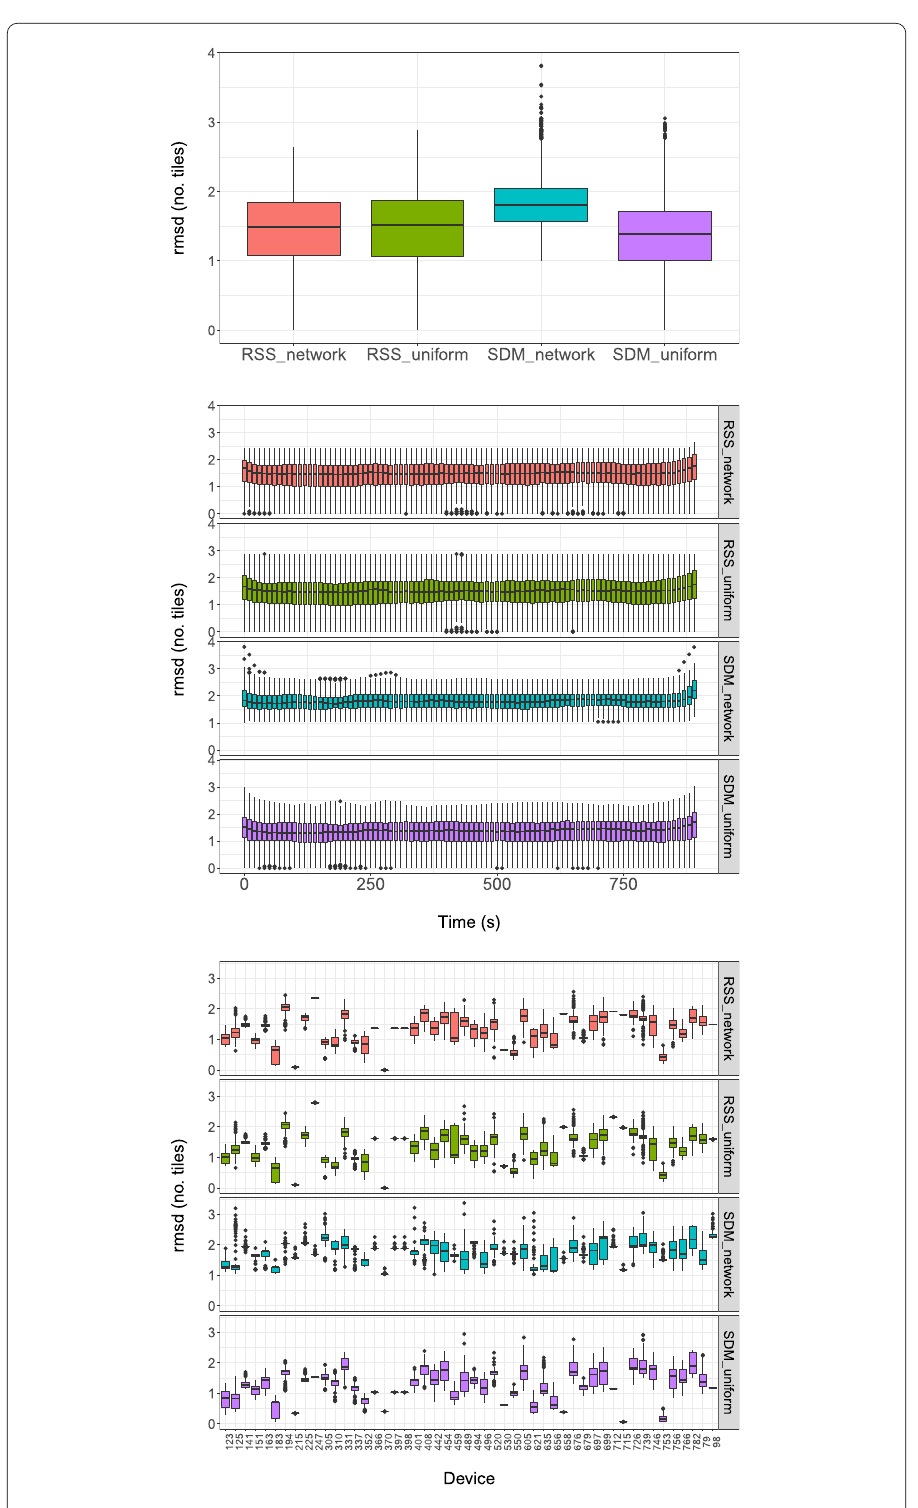
Figure 6 Root mean squared dispersions of location probabilities. (Top) Distribution of root mean squared dispersions rmsd dt for models RSS and SDM with uniform and network priors. (Middle) Time evolution of distributions of distance rmsd dt for the same models. (Bottom) Distribution per device of root mean squared dispersion rmsd dt for all times t for the same models (only 50 randomly selected are